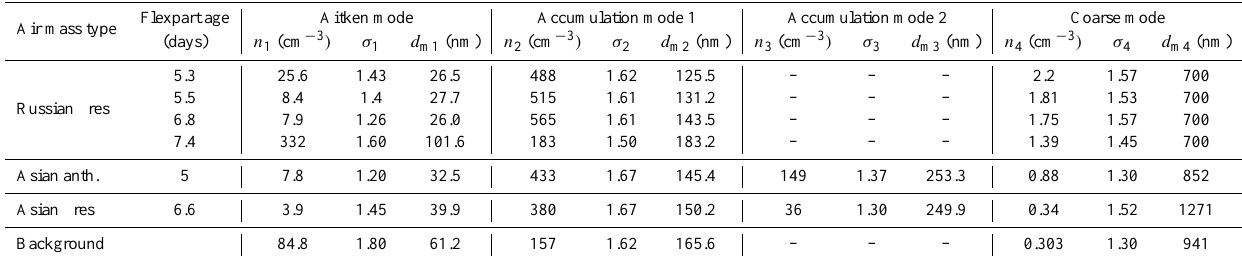
Table 5. Parameterisation of log-normally fitted size distributions for forest fire plumes. FLEXPART determined air mass ages are also indicated.